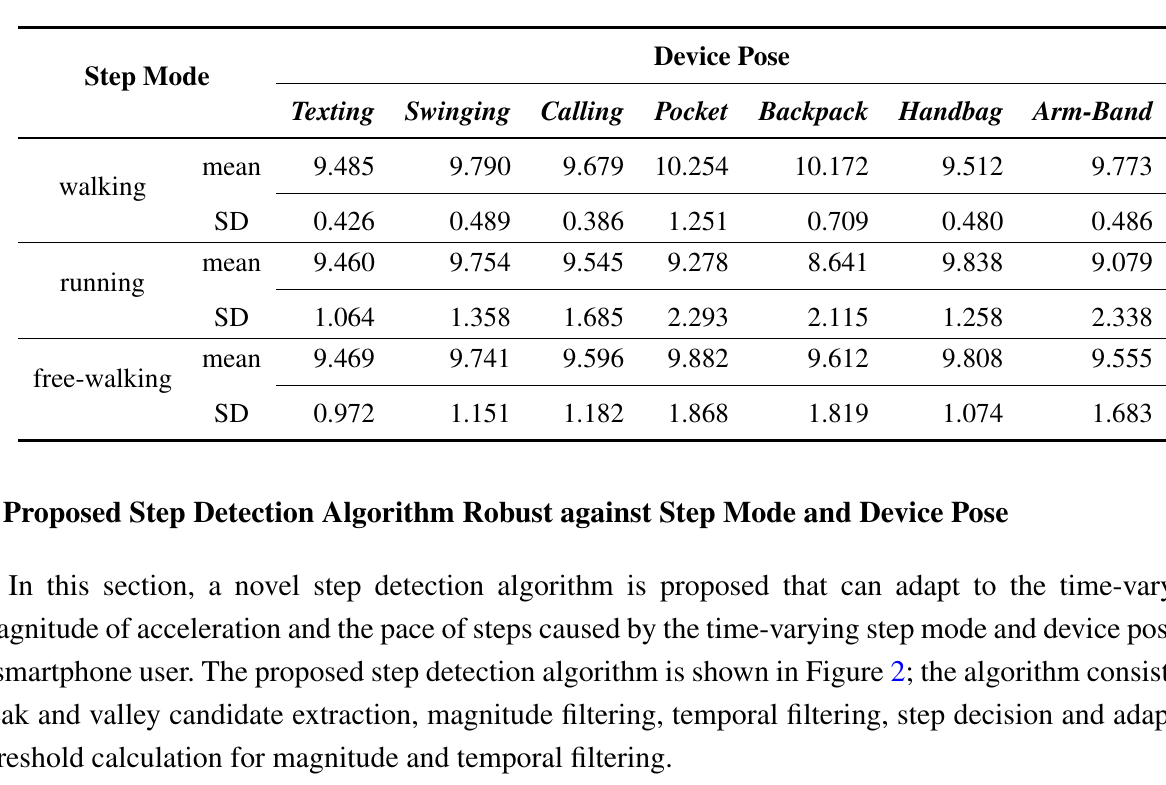
Table 1. Statistics of the magnitude of acceleration in various smartphone usage environments (m/s 2 ).